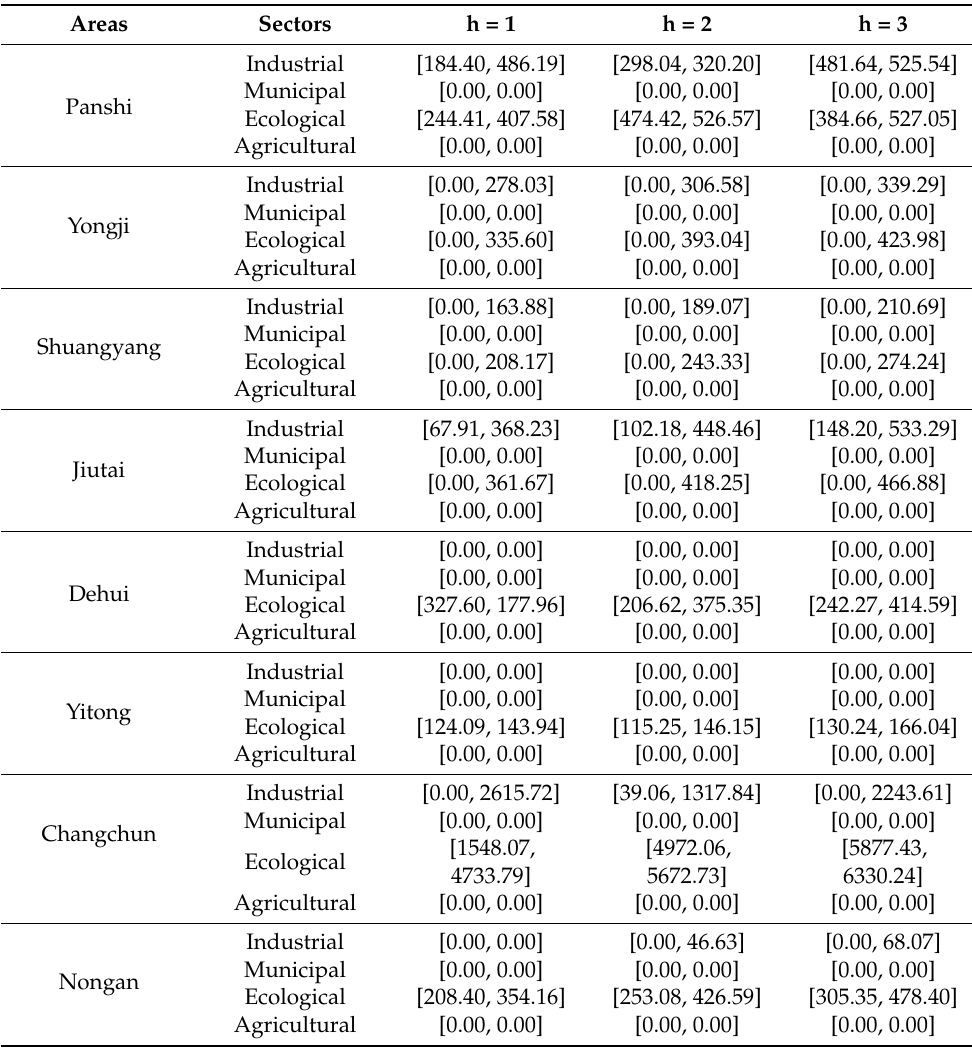
Table 3. The amount of reclaimed water under different levels of available water resources in the Yinma River Basin (10 4 m 3